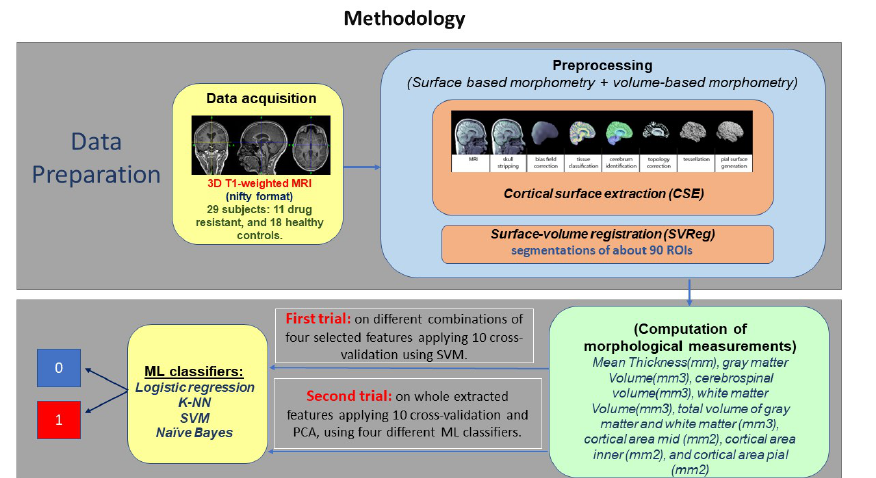
Figure 4. Schematic of the